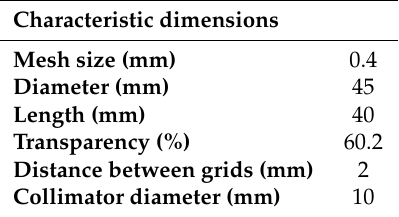
Table 4. RPA—Characteristic